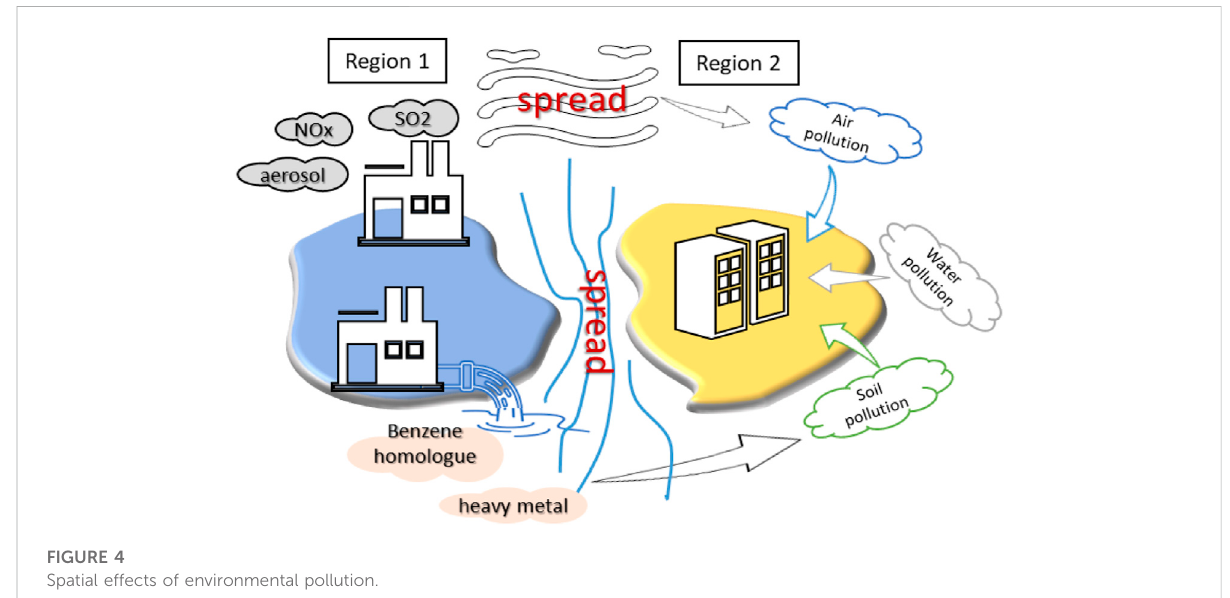
FIGURE 4 Spatial effects of environmental pollution.